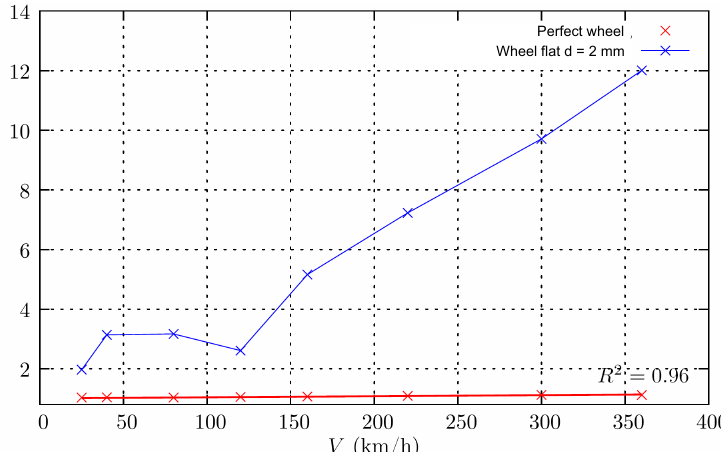
Figure 12. Dynamic amplification factor for the dynamic load: perfect wheel vs. flat wheel ( d = 2 mm), slab track.